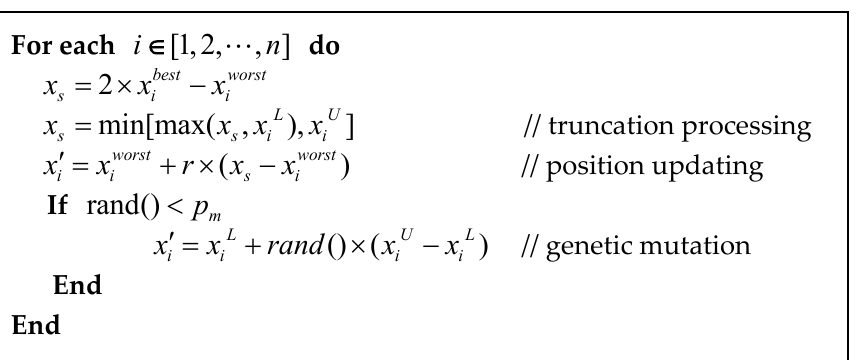
5 of 20 Figure 1. Generating a new harmony by classical HS algorithm. Here,